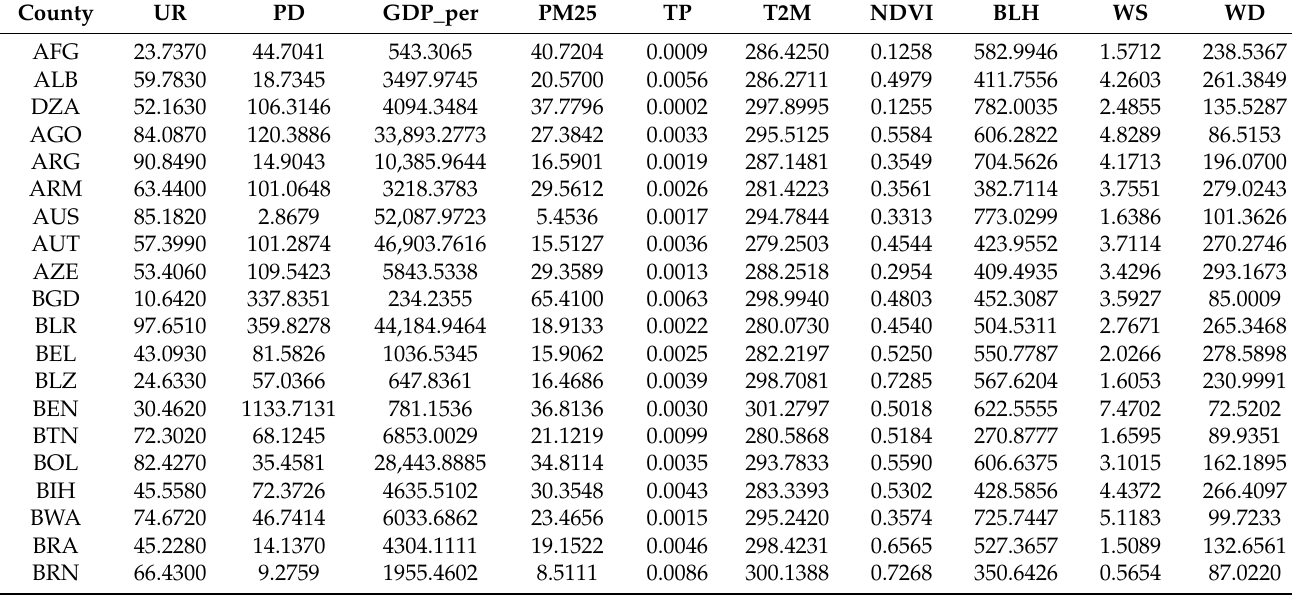
Table A2. Year-wise mean value of all the parameters in